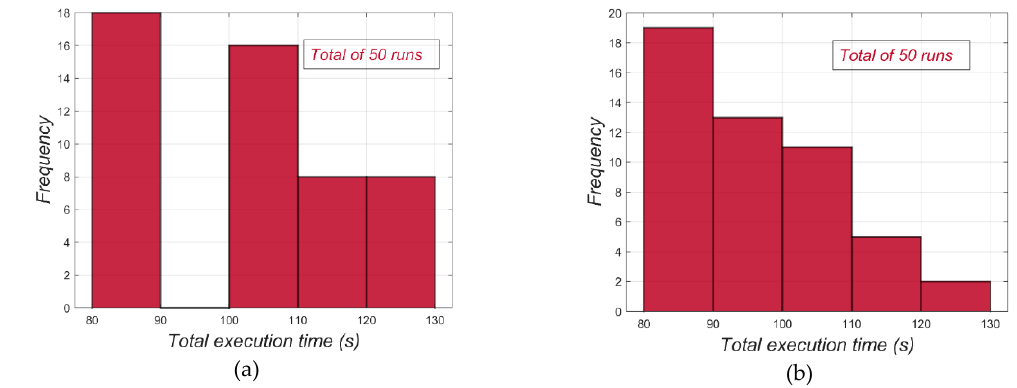
Figure 7. Total execution time for the ( a ) Polish dataset errors using LCB-BO and ( b ) Brazilian dataset